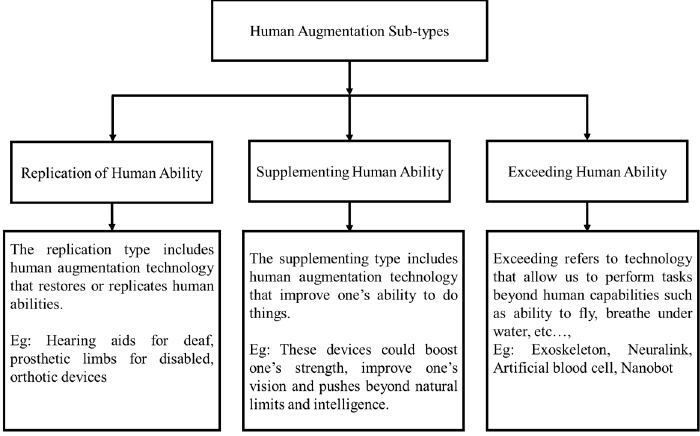
Figure 10. Sub-types and innovation action points of HA.